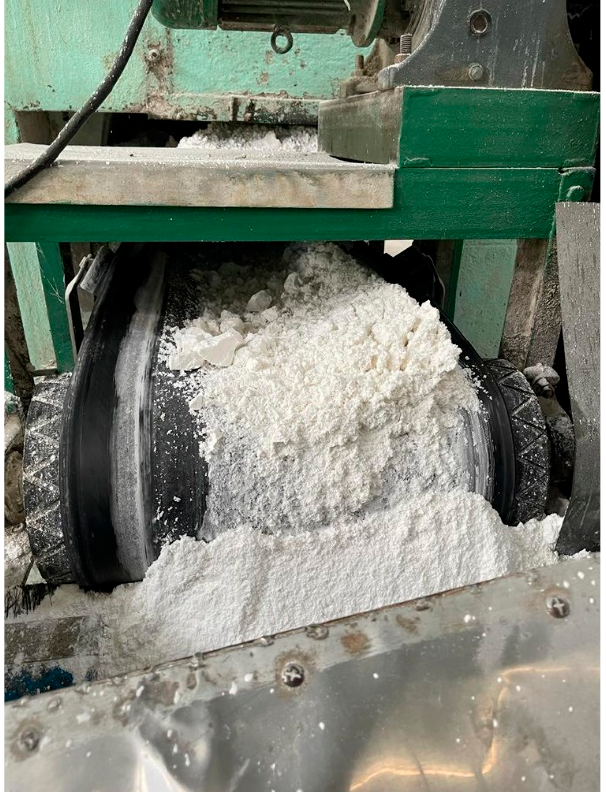
Figure 3. The rejected sago starch, which did not meet the requirement of premium quality for domestic and export purposes.